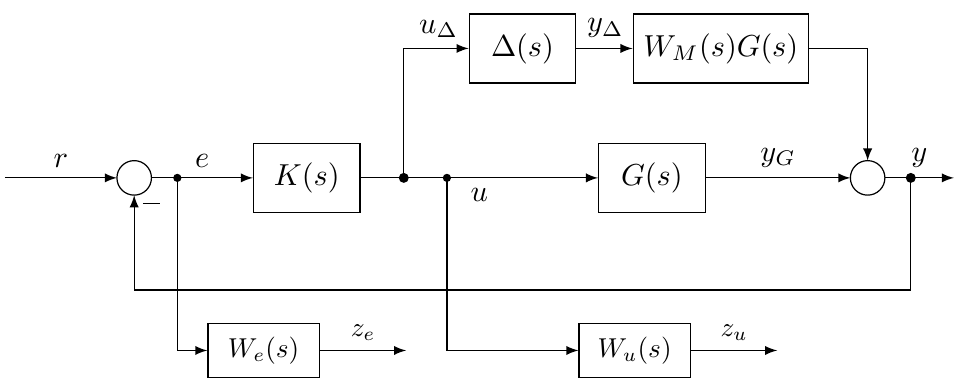
Figure 8. Closed-loop uncertain system with the weighting